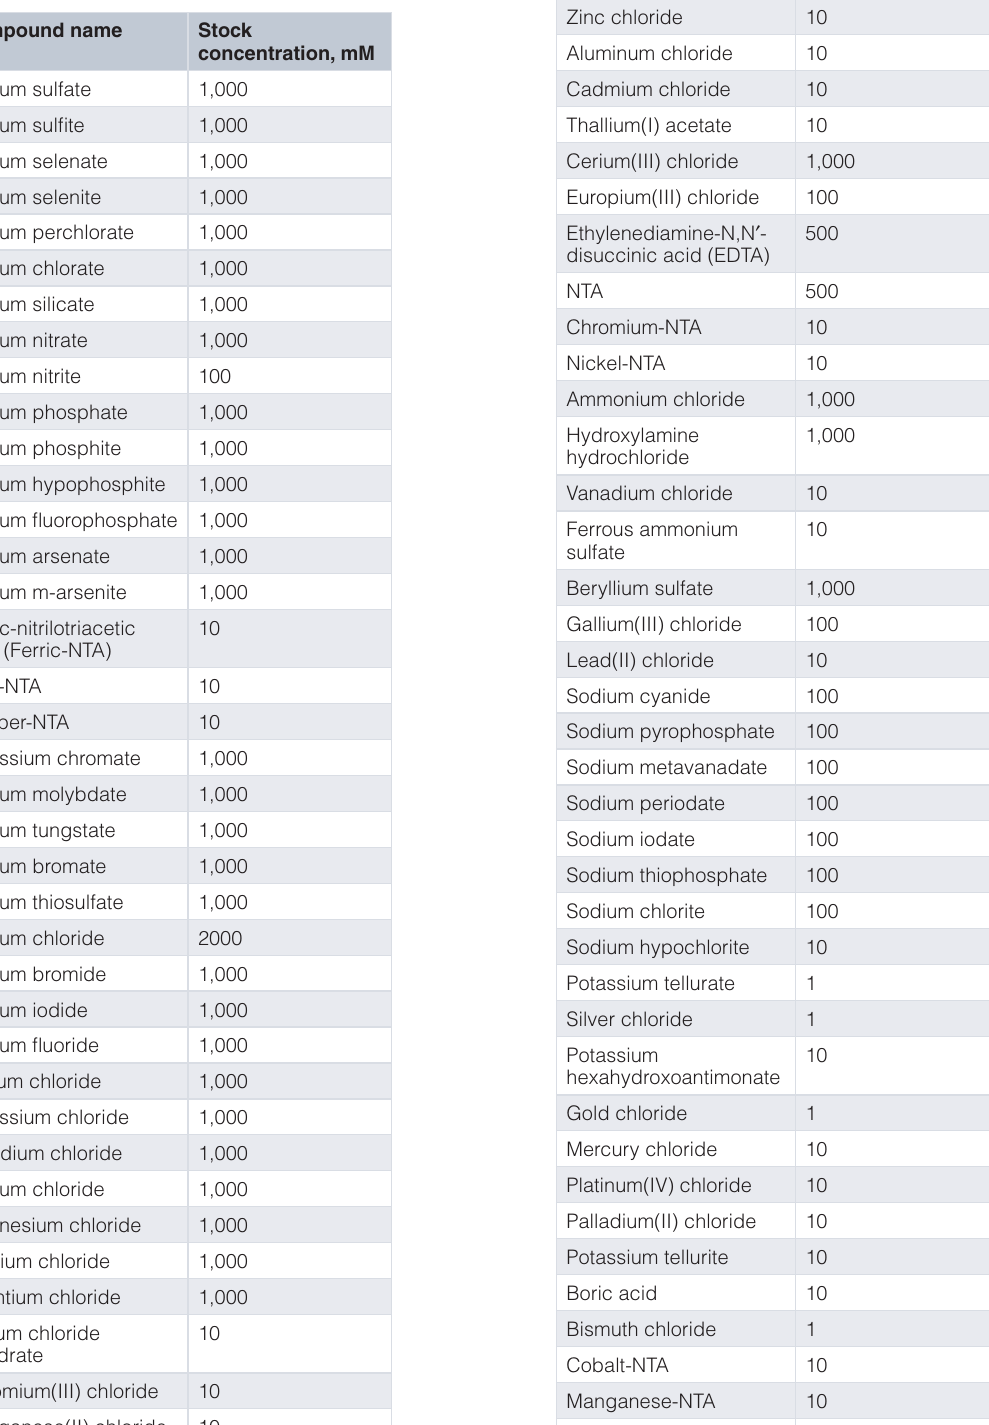
Table 1. 80 metals